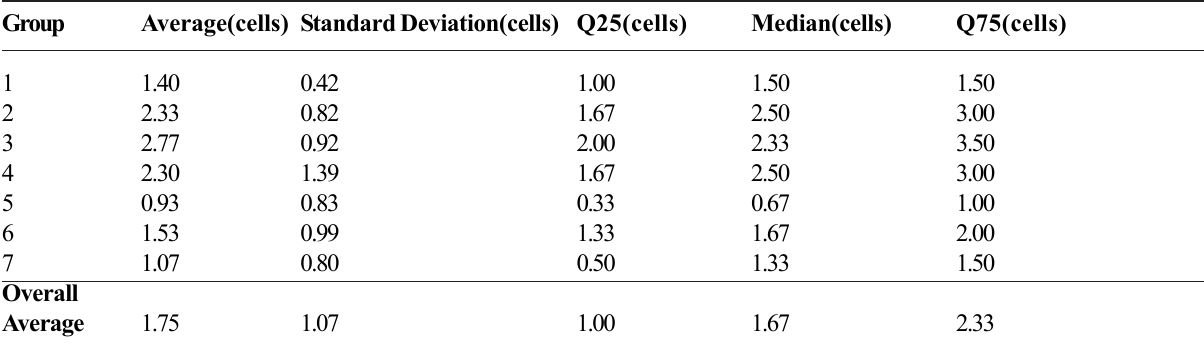
TABLE 6 — Measures of isolated macrophage cells (cells), with Arithmetical Average, Standard Deviation, Q25, Median, Q75 of all Groups, individually and